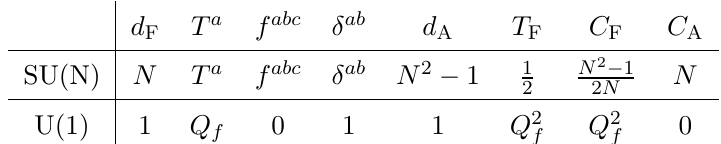
Table 1 . Values of the various group-theoretical quantities for SU(N) and U(1) gauge theories. In Q f , T Q 2 Q 2 the U(1) case the replacements T a and C F involve the charge Q f , where F ! f f ! ! f is the fermion on which T a , T C F or F acts. For diagrams that involve external fermions one Q 2 should use the substitution C F at one loop, and the two-loop substitutions C 2 f ! P n T C Q 2 Q 2 , where the sum runs over all fermions f 0 that circulate in closed loops. f F F ! f f 0 f 0 2 F Instead, for vertices without external fermions one should use the one-loop substitutions n f T F P Q 2 m 2 Q 2 m 2 and T F P , and the two-loop substitutions n f T F C F f 0 f 0 ! f 0 f 0 f 0 f 0 f 0